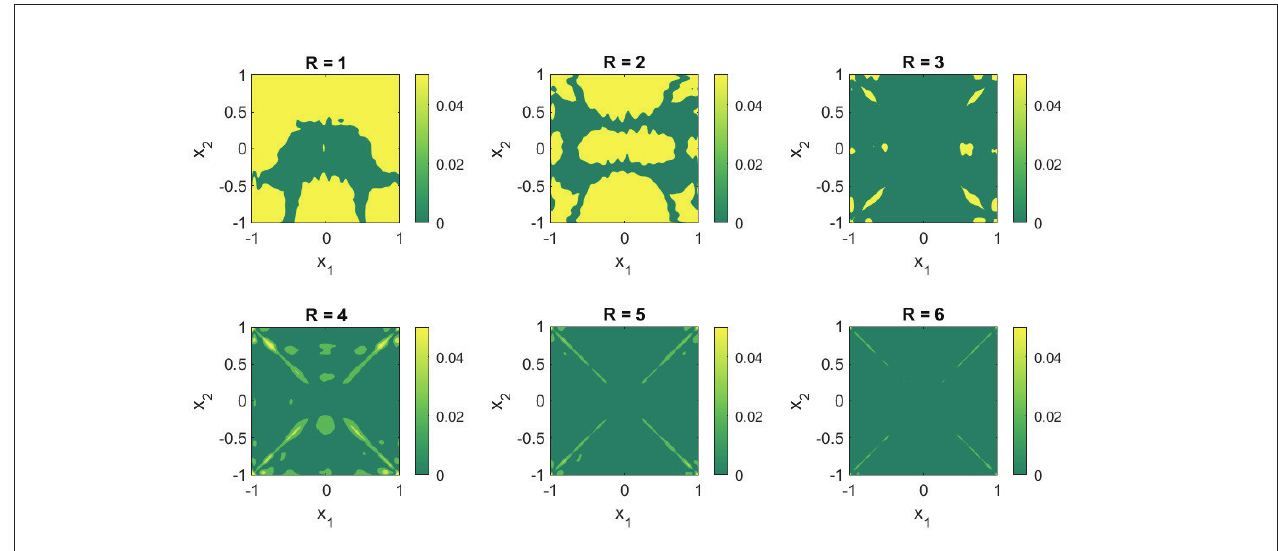
x 1 x 2 in Equation (19) with | || |